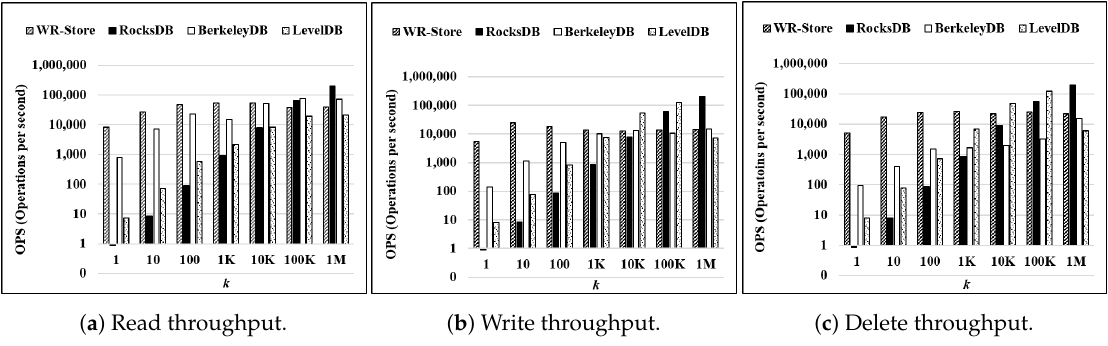
Figure 9. Throughput on a synthetic data set as the number of continuous operations k is increased.